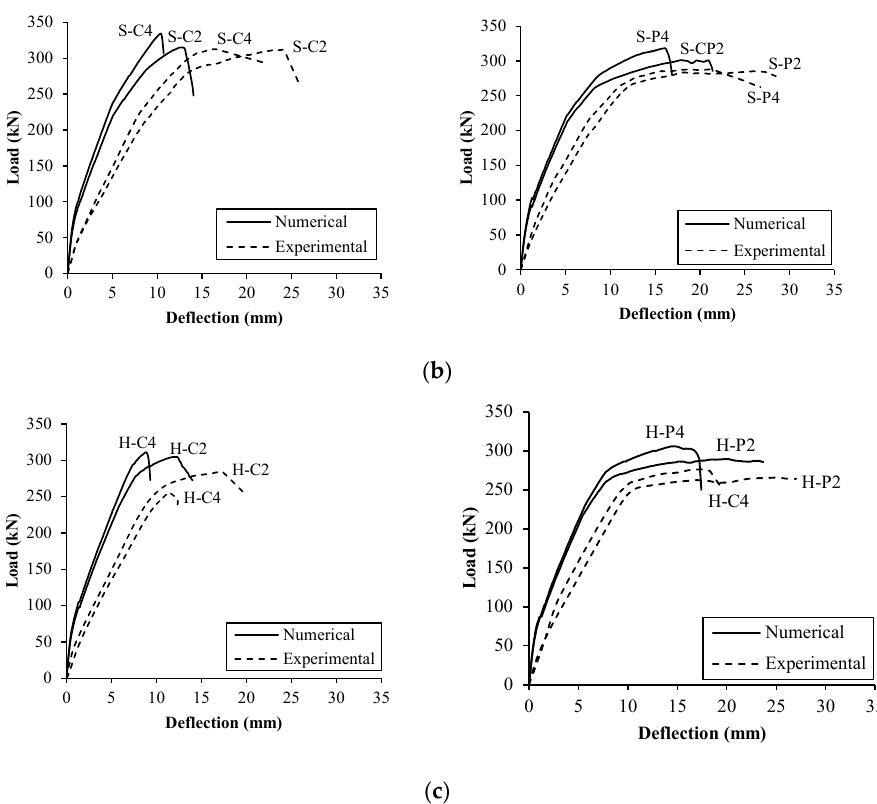
Figure 18. Numerical vs. experimental load-deflection response: ( a ) Control; ( b ) Group A (sagging strengthening); ( c ) Group B (hogging strengthening). The load versus moment relationships predicted numerically are shown in Figure 19.